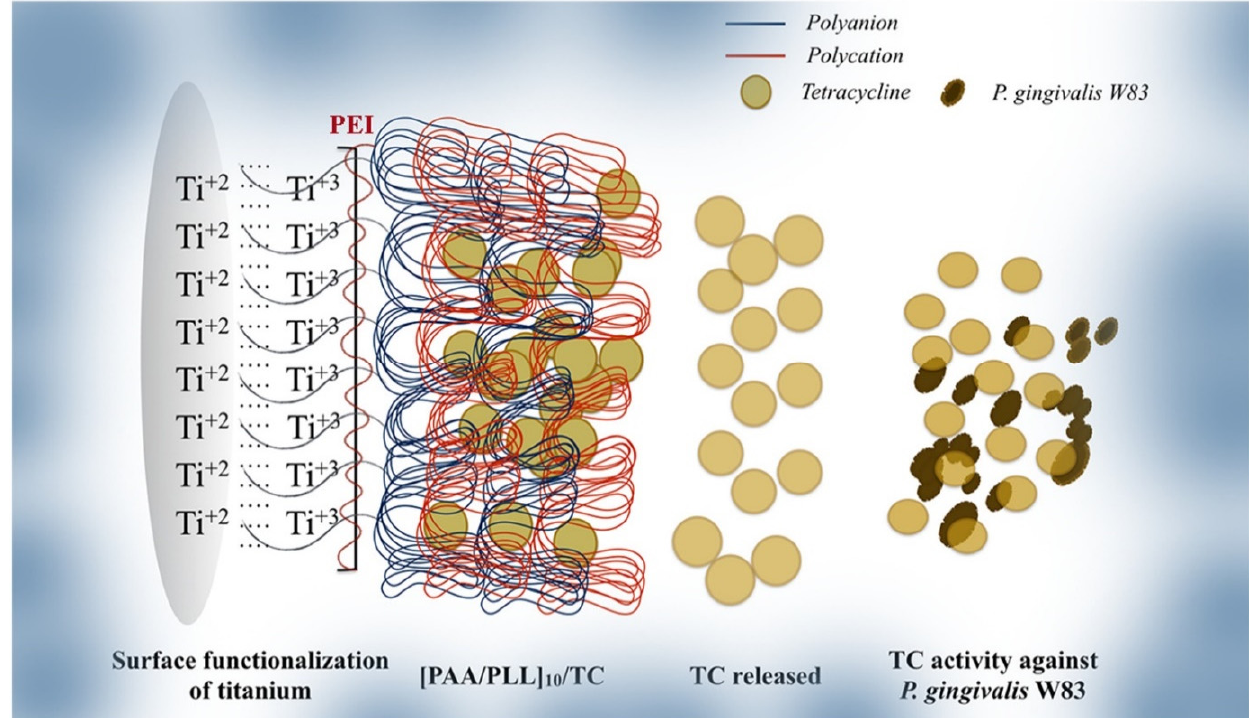
Figure 3. Illustration of the surface functionalization of layer-by-layer polyelectrolyte depositions of PAA and PLL on titanium implants for the sustained release of tetracycline [95]; reproduced with permission from [95], Elsevier B.V. Ltd., 2019.